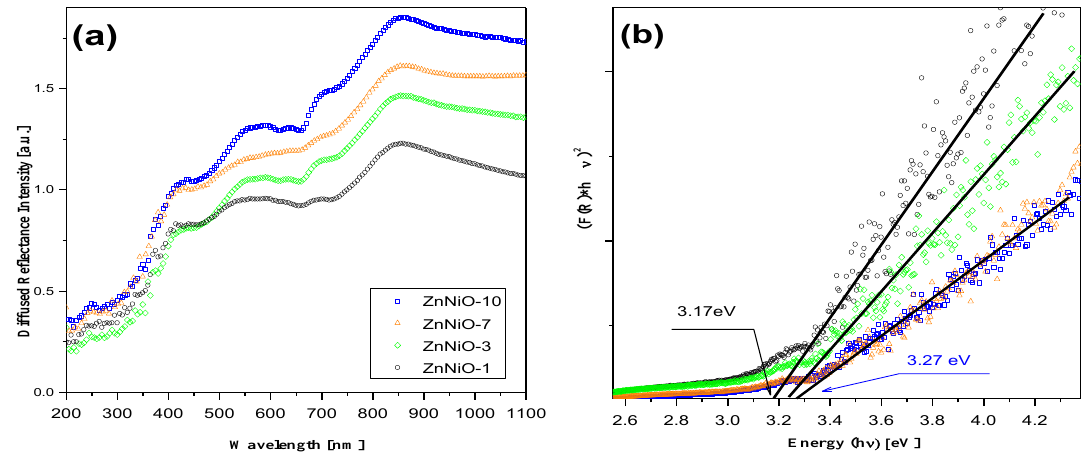
Figure 4. ( a ) The UV-VIS diffuse reflectance spectra for ZnNiO pellets are vertically stacked and plotted in the increasing Ni doping order. The doping percentages in samples, ZnNiO-1, -3, -7 and -10%, are correspondingly plotted in black, green, red and blue colored spectral lines. ( b ) Kubelka-Munk fittings of the DRS are plotted in the right-hand side figure.